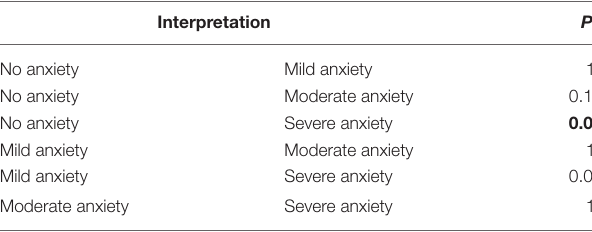
t = − 1.97; p = 0.049; third wave: value − 2.182; SD 0.836; t = − 2.61; p = 0.009).